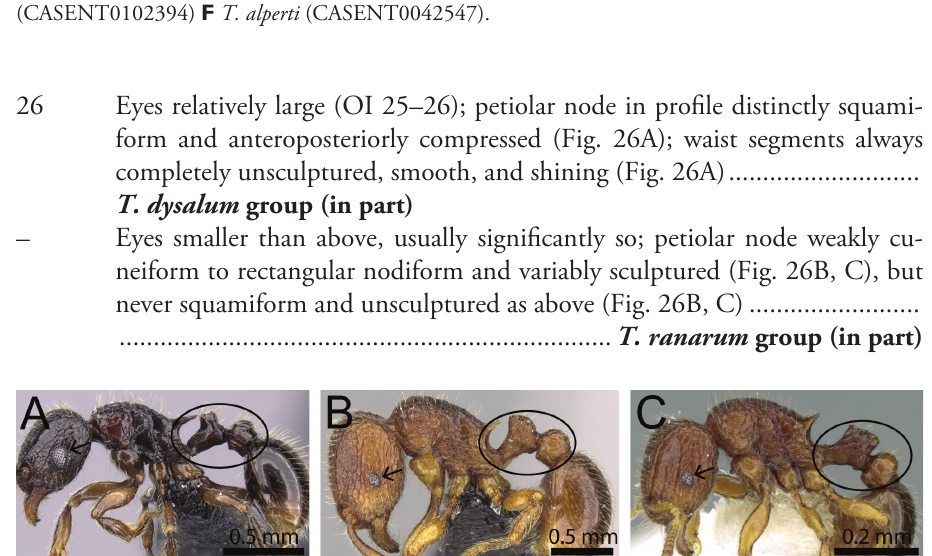
Figure 26. Body in profile (black arrows indicate eyes; wait segments within black ellipses). A T. am- batovy (CASENT0124721) B T. fhg-mogw (CASENT0056452) C T. zenatum